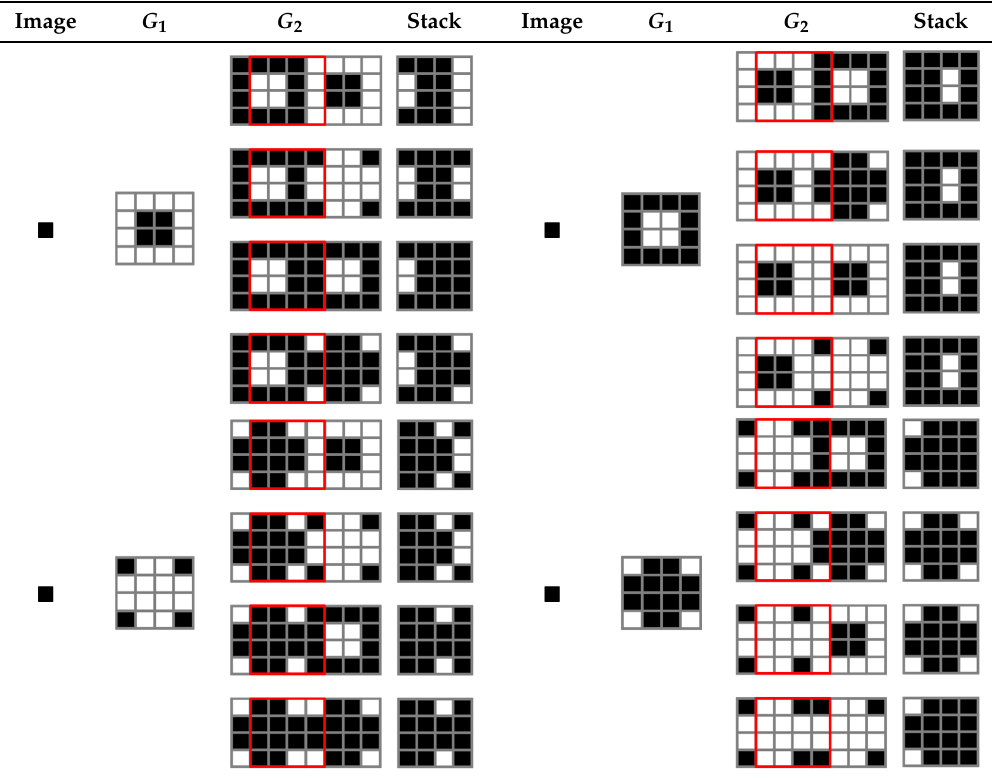
Table 8. The analysis of stacked units with one pixel shift when the pixel in the secret image is black.